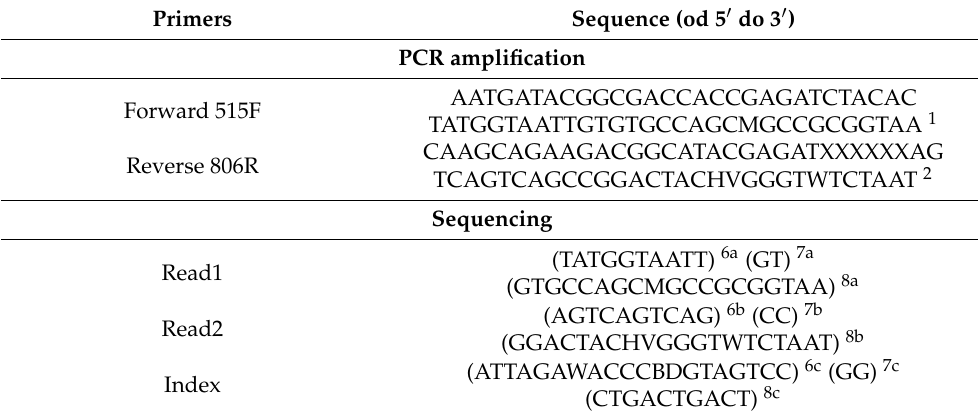
Table 3. Primers used in the amplification reaction and for sequencing